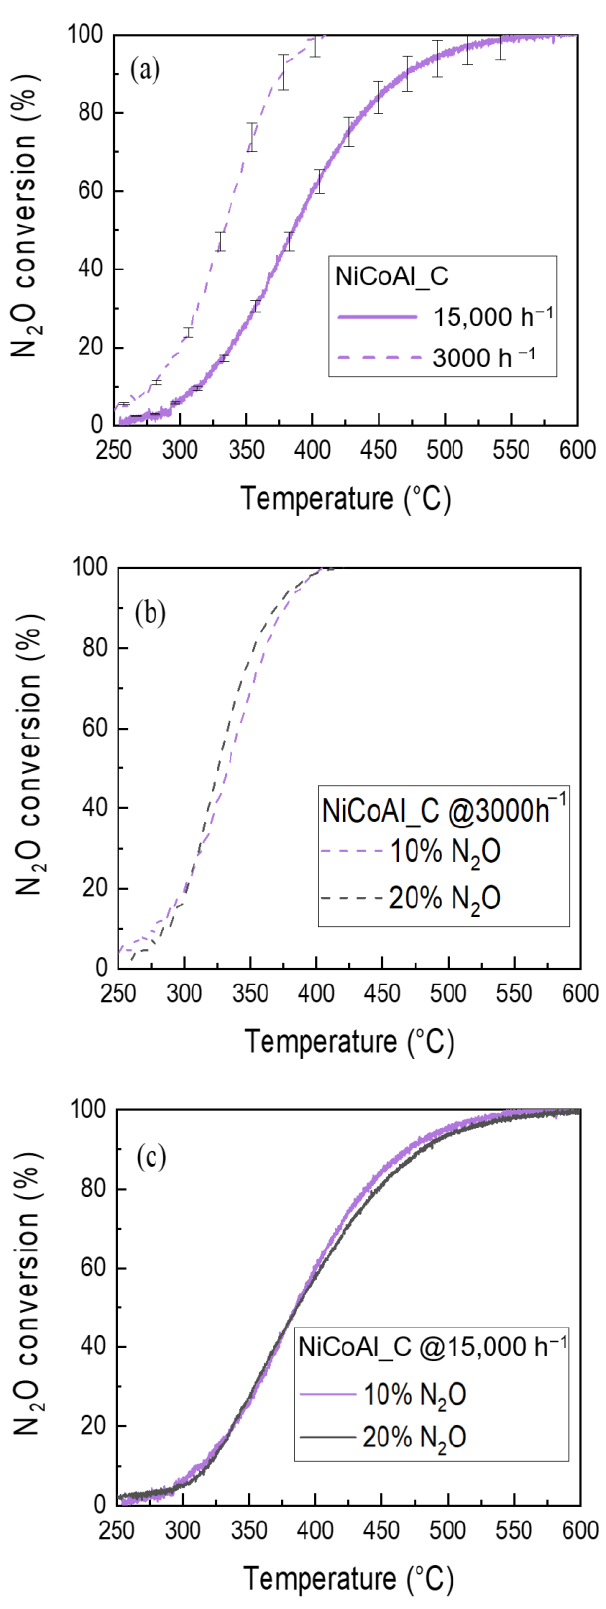
Figure 13. ( a ) GHSV effect in catalytic N 2 O decomposition over NiCoAl_C catalyst (reagent mixture: 20 vol% N 2 O in Ar); ( b ) effect of N 2 O concentration at GHSV = 3000 h − 1 , 1 atm; ( c ) effect of N 2 O concentration at GHSV = 15,000 h − 1 , 1 atm.